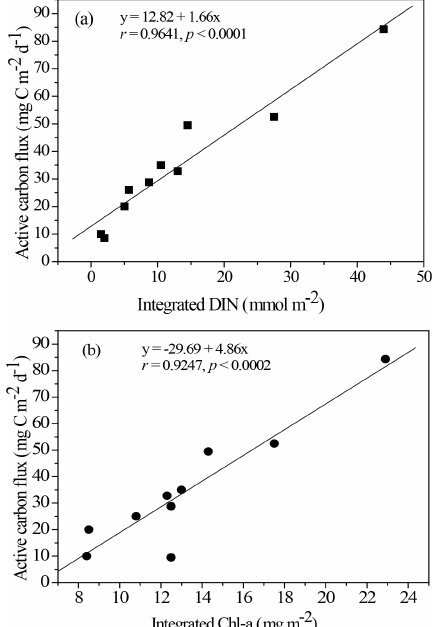
Figure 5. Empirical relationship between active carbon fluxes and DIN inventories in the euphotic zone (a) and between active carbon fluxes and Chl a inventories in the euphotic zone (b) . The statistic correlations were established from collected data in all expeditions.